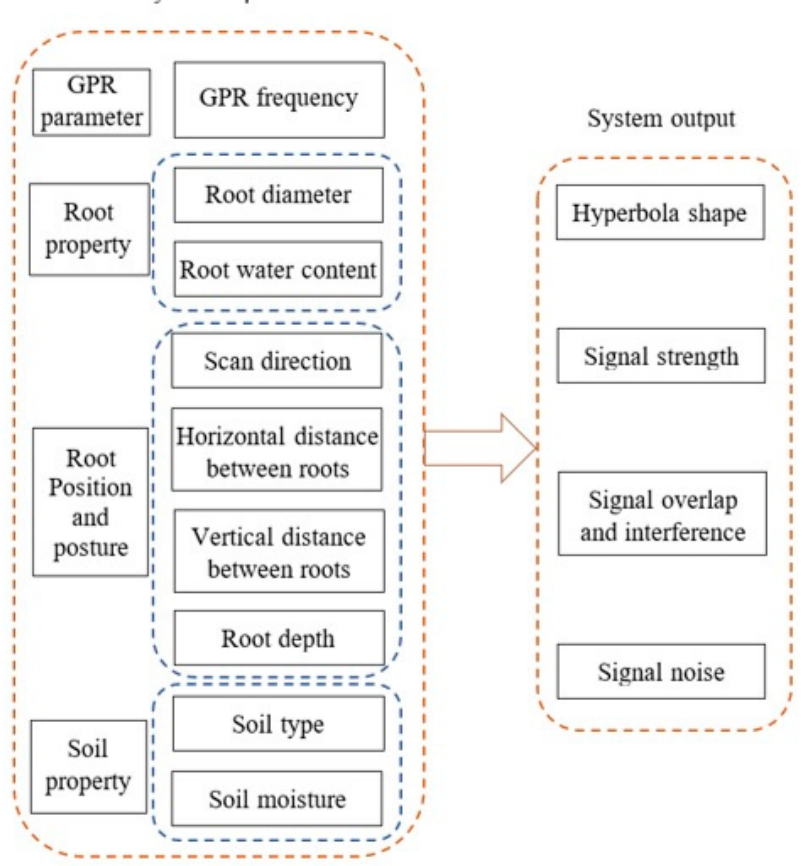
Figure 3. Input factors and output parameters of the experimental design.